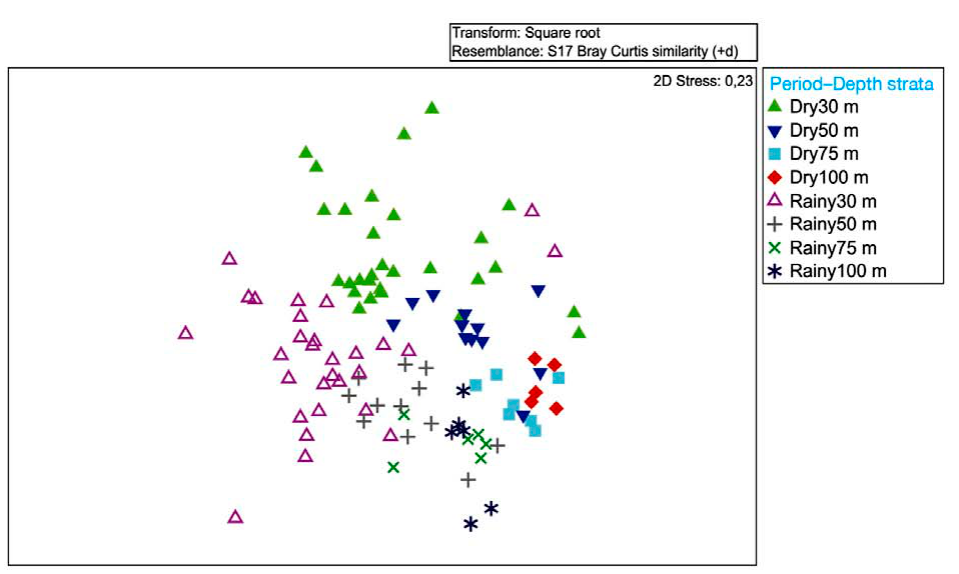
Fig. 5. – MDS relative to the dry and wet period collection and depths of 30, 50, 75 and 100 m in each